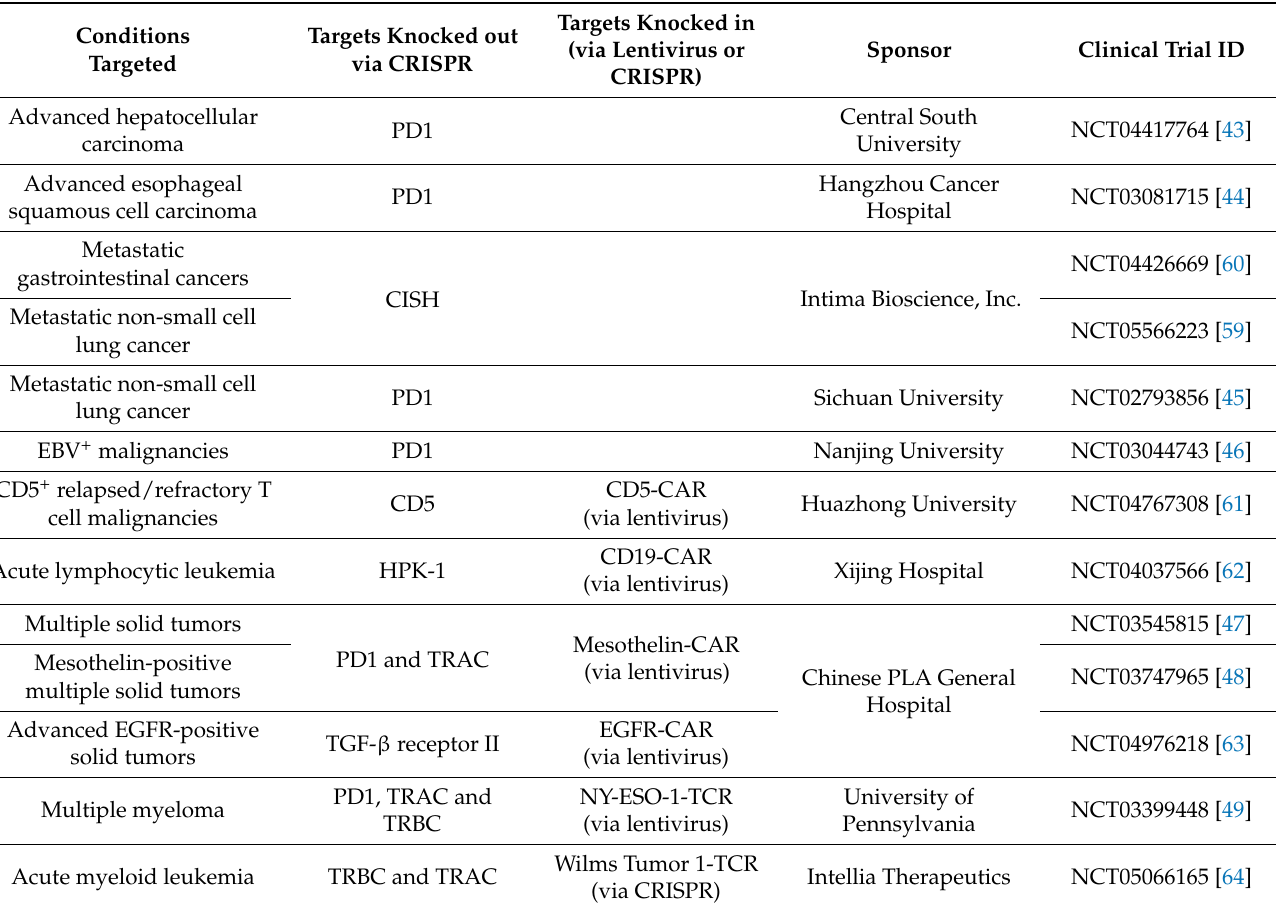
Table 1. List of autologous cellular immunotherapies using the CRISPR-Cas9-based gene editing